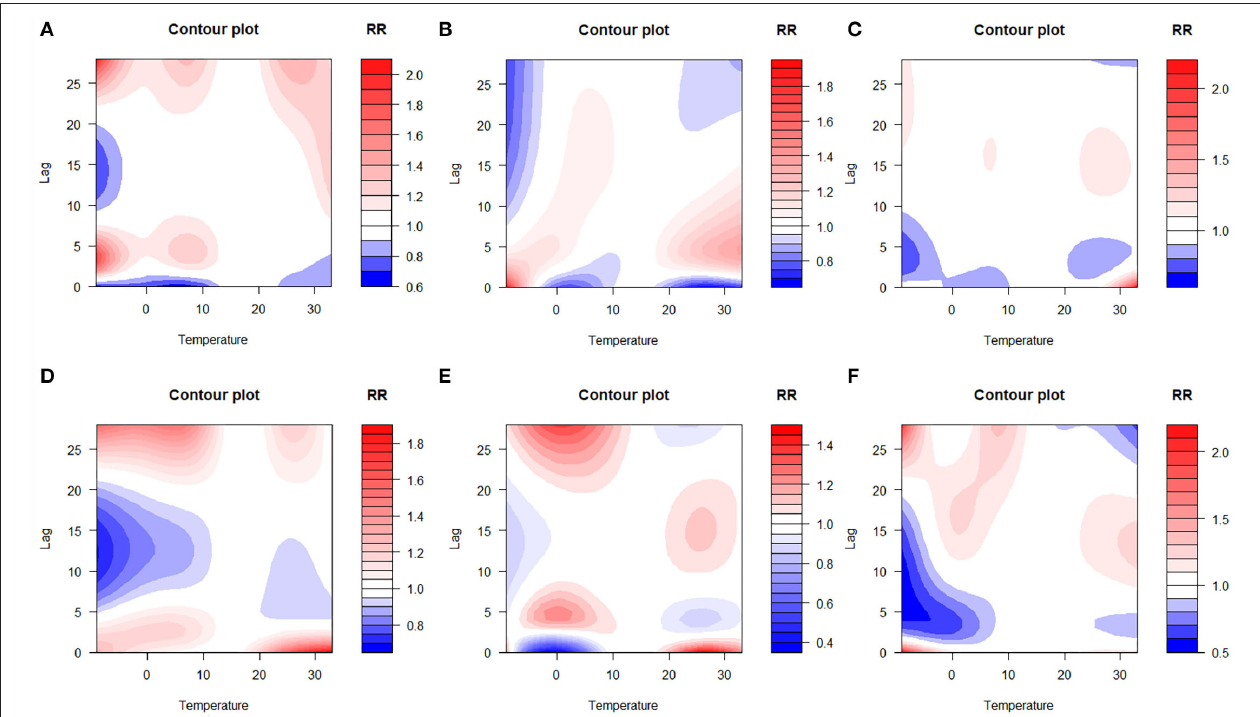
FIGURE 7 | Contour plots of lag–response to temperature based on the age stratification [ (A) age ≤ 30 group; (B) 30 < age ≤ 40 group; (C) 40 < age ≤ 50; (D) 50 < age ≤ 60; (E) 60 < age ≤ 70; (F) age > 70].